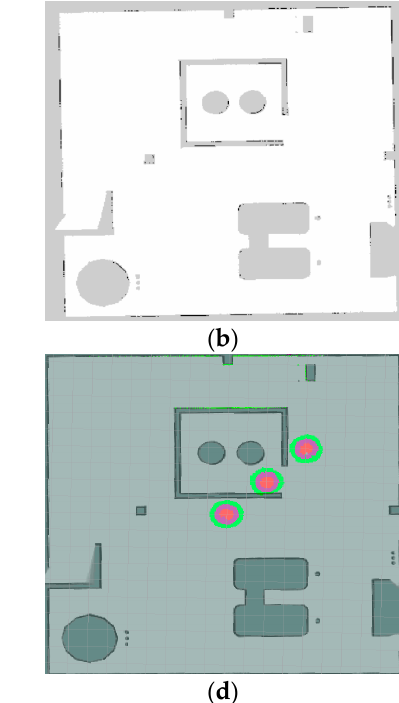
environment, ( c ) single-radiation-source map-fusion results, and ( d ) multi-radiation-source map-fusion results.